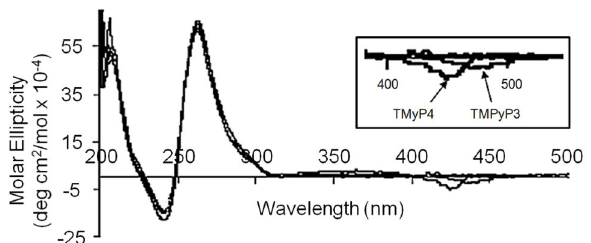
Figure 2. CD spectra for complex of the 39-mer Bcl-2 P1 promoter G-quadruplex saturated with bound TMPyP4, TMPyP3, or TMPyP2. The inset shows an expanded view of the CD spectra in the range of the porphyrin absorption spectrum. The very small negative CD signals in the 400-450 nm range are only observed in the presence of excess porphyrin for TMPyP4 and